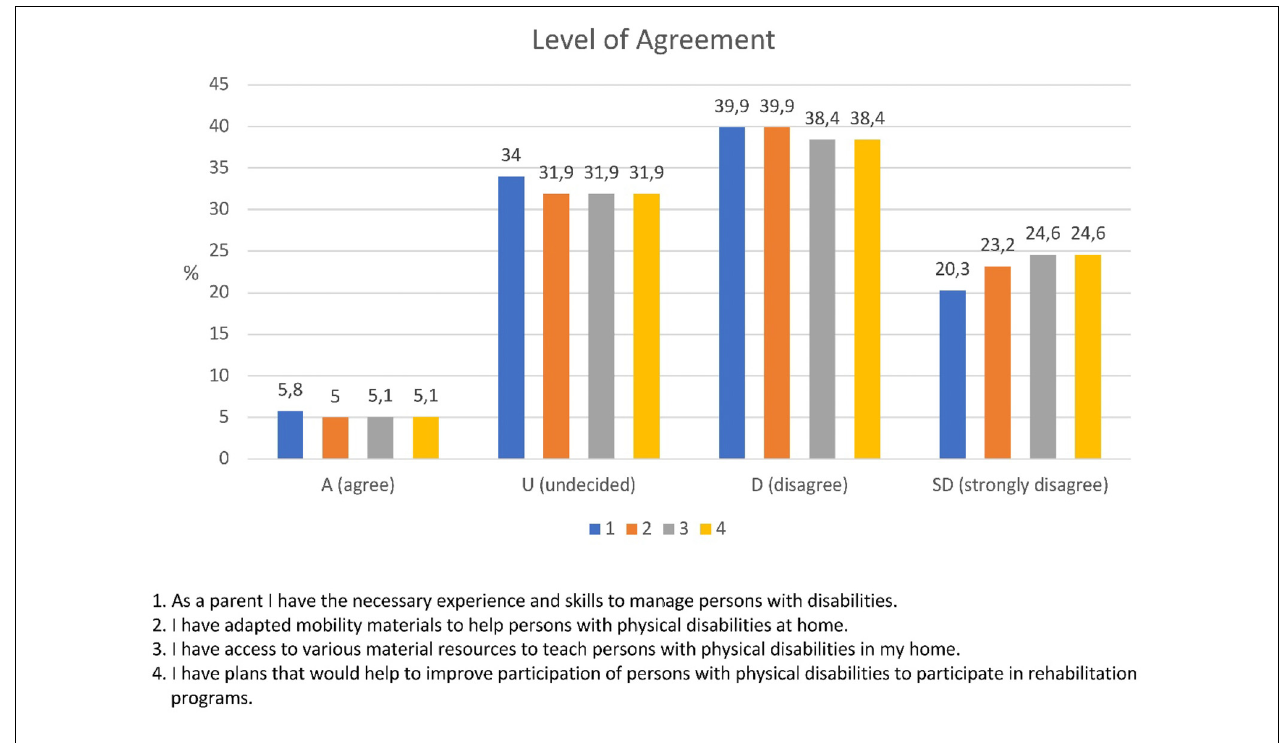
FIGURE 5 | Parental experience and skills in treating persons with disabilities at home.